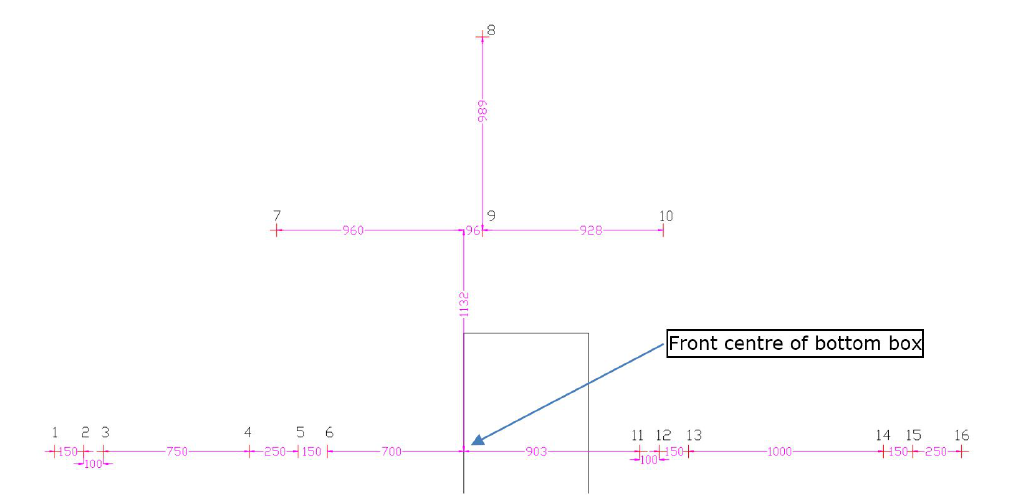
Figure 6. Plan view of the position of the 16 wave gauges in the basin. Measurements are in mm and referred to the centre of the front of the bottom